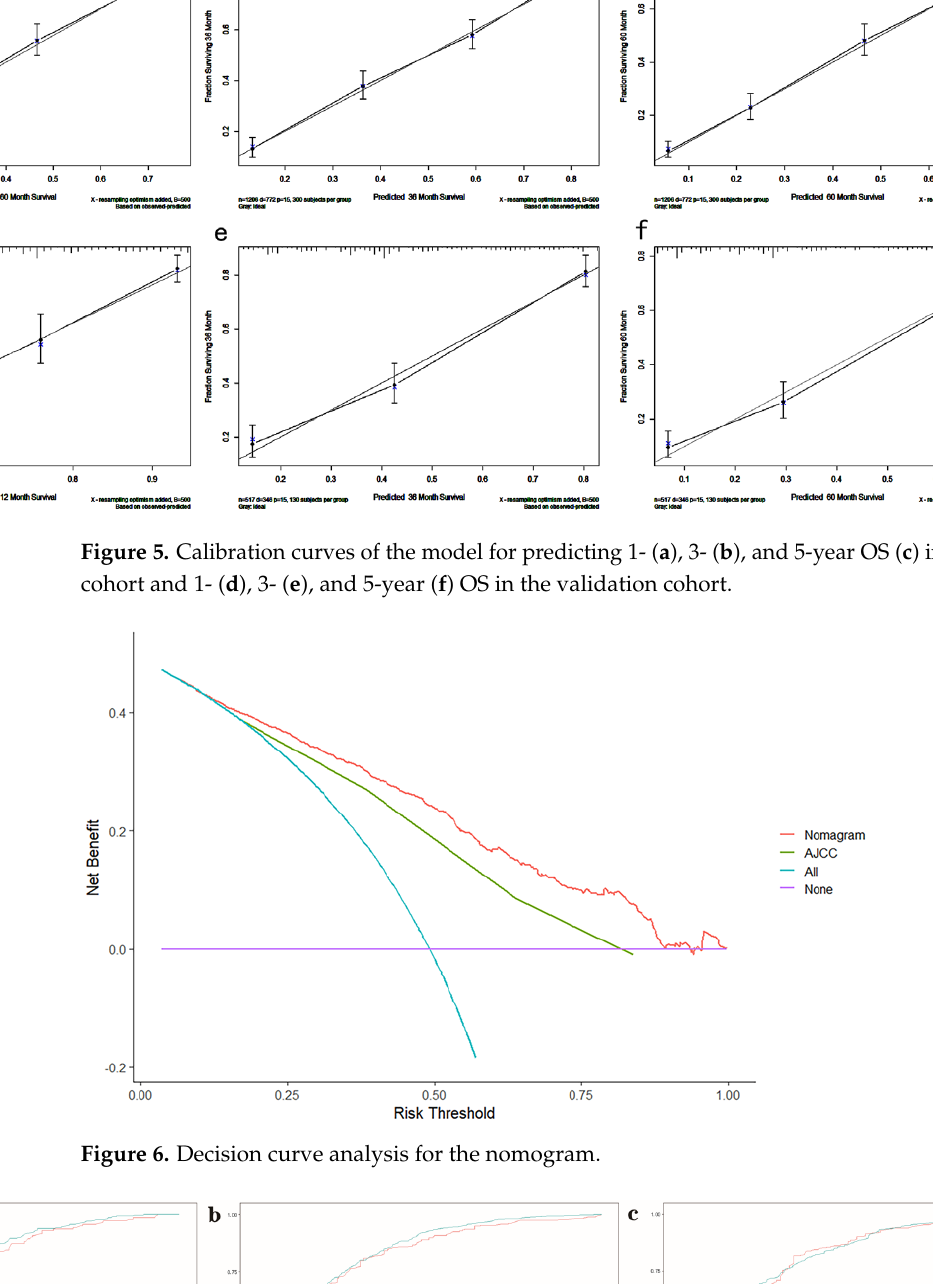
Figure 6. Decision curve analysis for the nomogram.